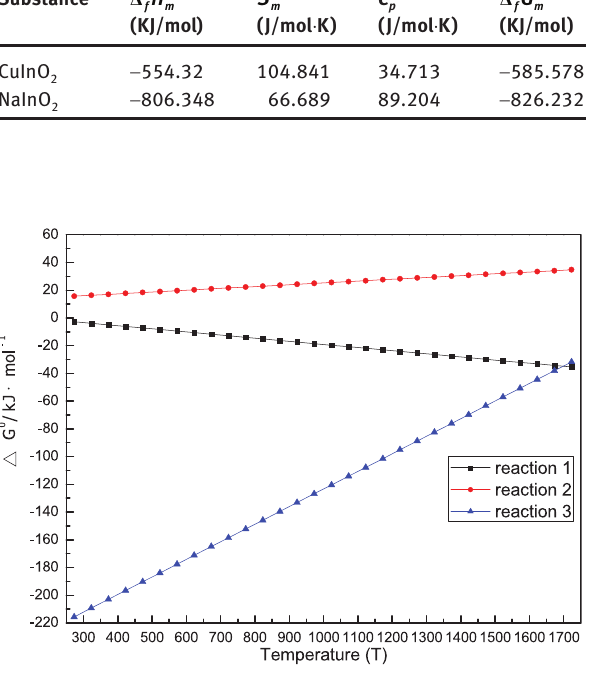
Table 5: Standard thermodynamic data of formation at 298 K Substance